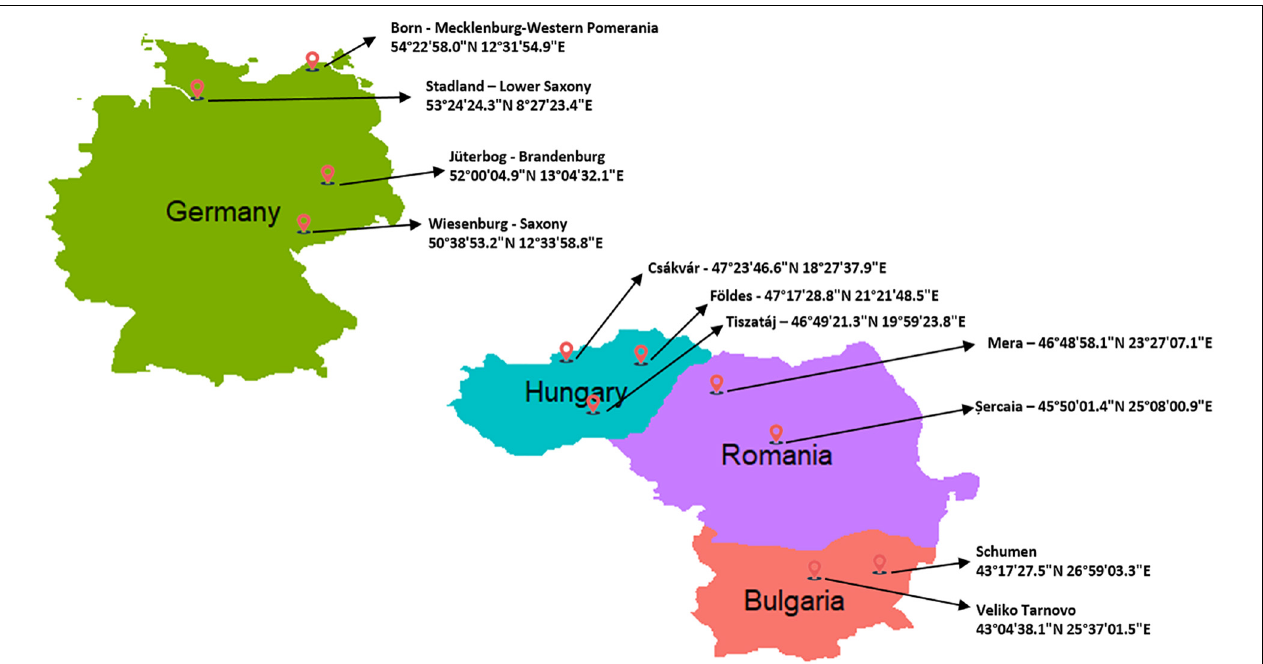
FIGURE 1 | Geographic map showing the locations with specific coordinates the buffalo samples were collected from, genotyped in the current study. The number of samples for each location are reported in Table 1 .